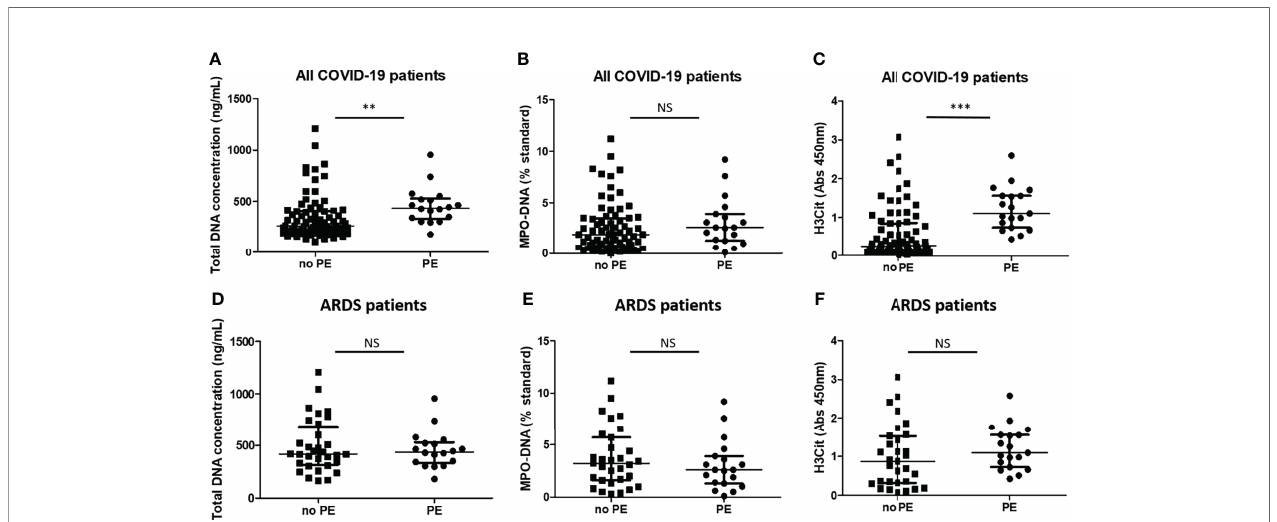
FIGURE 4 | Plasma total DNA concentrations and myeloperoxidase – DNA levels are higher in COVID-19 patients who will subsequently have pulmonary embolism but not when assessed by comparable severity. Plasma NET levels were compared between COVID-19 patients who will subsequently develop pulmonary embolism (PE) (n = 19) and those who will not (n = 77). (A) Total DNA concentration (ng/ml). (B) Myeloperoxidase – DNA levels (standard NETs). (C) Histone H3 citrullinated (absorbance 450 nm). Plasma NET levels were compared between COVID-19-related acute respiratory distress syndrome patients who will subsequently develop pulmonary embolism (PE) (n = 18) and those who will not (n = 32). (D) Total DNA concentration (ng/ml). (E) Myeloperoxidase – DNA levels (standard NETs). (F) Histone H3 citrullinated (absorbance 450 nm). **p < 0.01, ***p < 0.001, NS, statistically non-signi fi